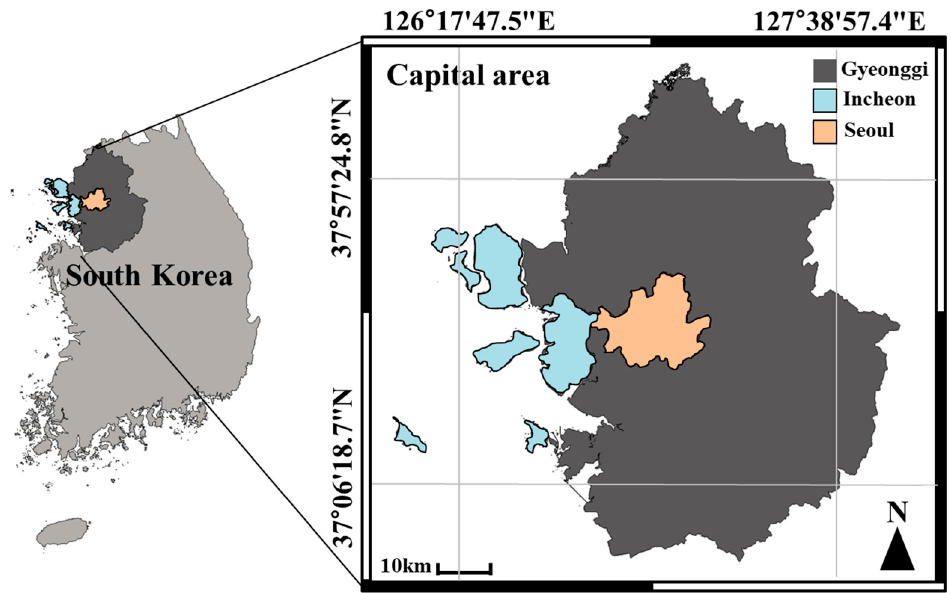
Figure 3. Study area, capital area of South Korea including Seoul, Incheon, and Gyeonggi province for deep learning model training and the other regions for the model generalization.